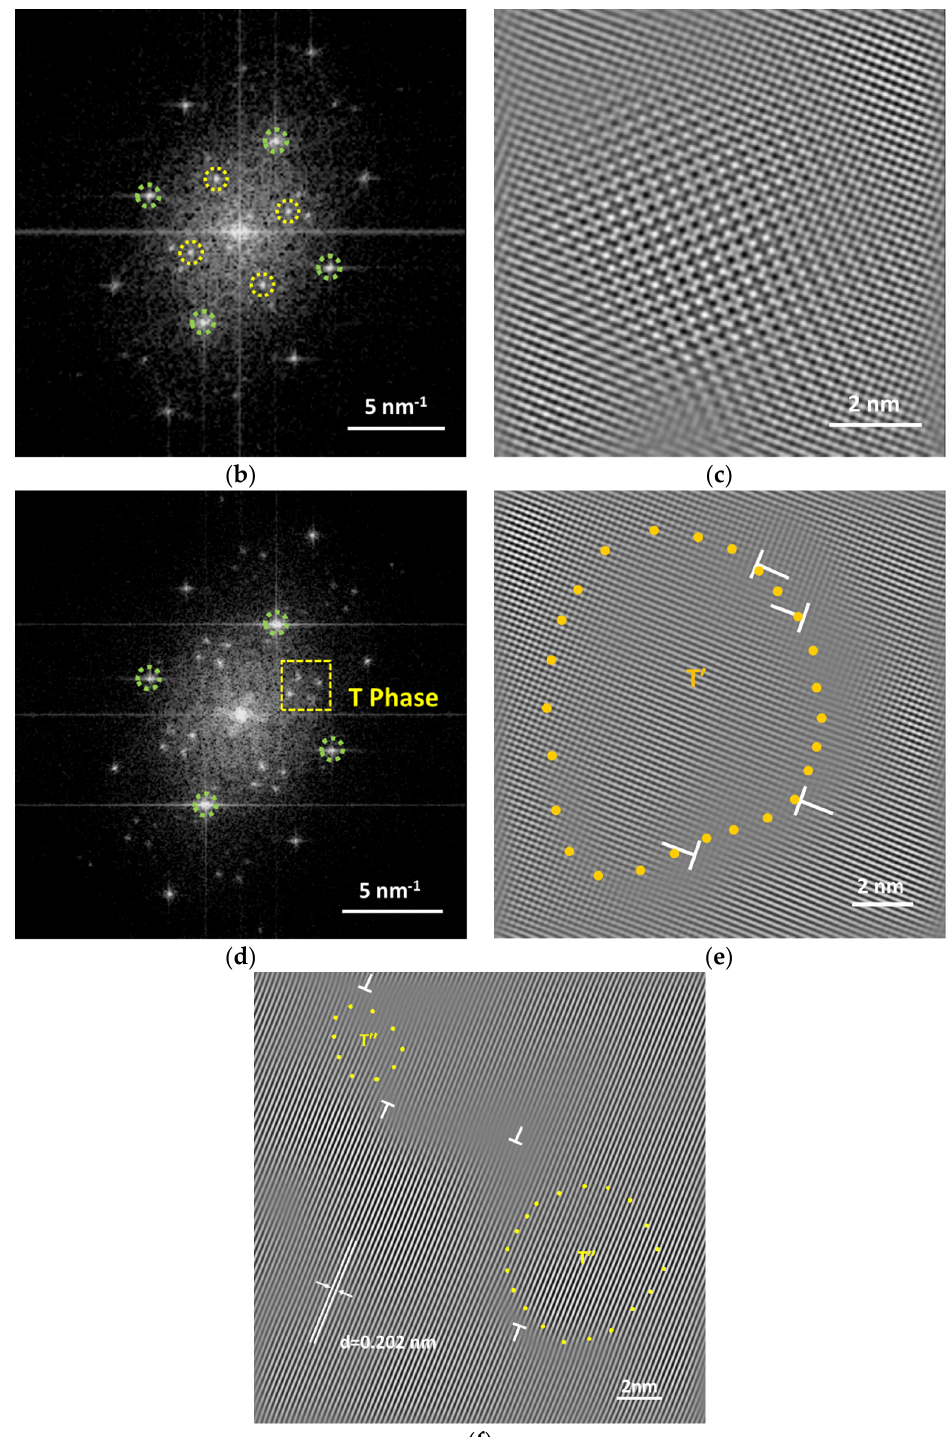
Figure 8. HRTEM images of FTMT–9–12–a sample: ( a ) typical HRTEM image; ( b ) FFT pa tt ern of square zone 2; ( c ) IFFT image generated from the pa tt ern in ( b ); ( d ) FFT pa tt ern of square zone 3; ( e ) IFFT image generated from the pa tt ern in ( d ); and ( f ) IFFT image corresponding to square zone 4.